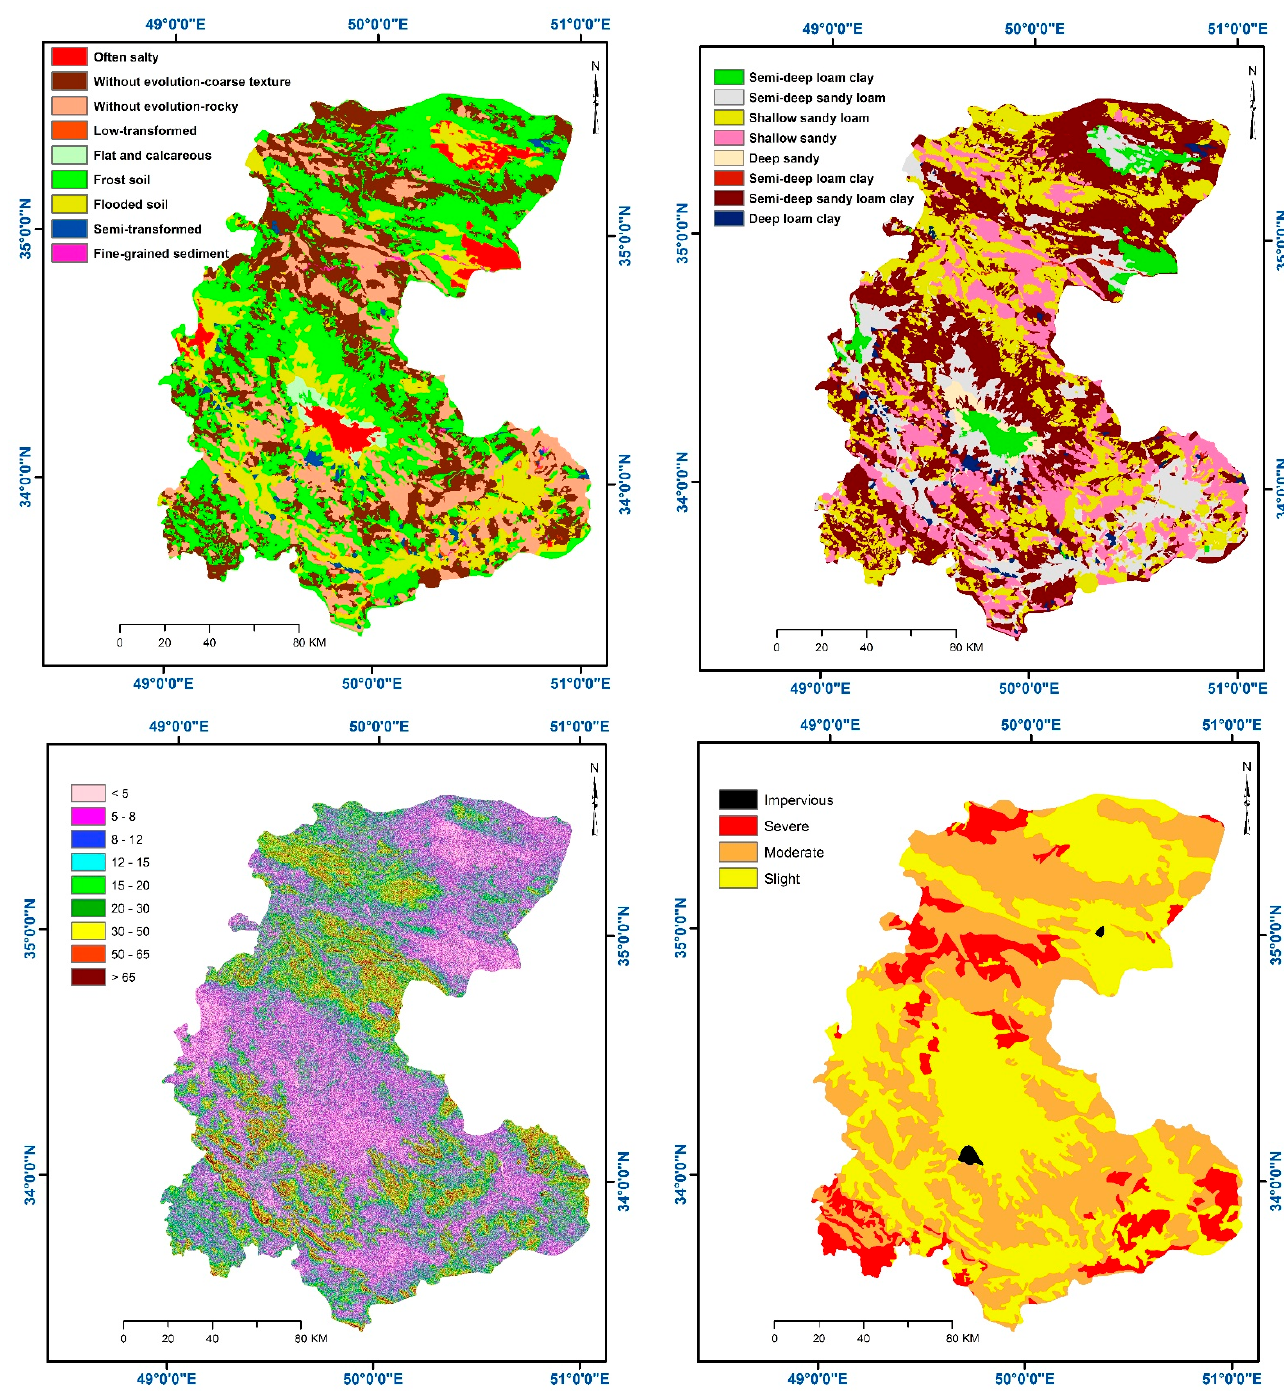
Figure 5. Classification map of each criterion: soil structure—top left; soil texture and depth—top right; slope (%)—bottom left; soil erosion—bottom right.